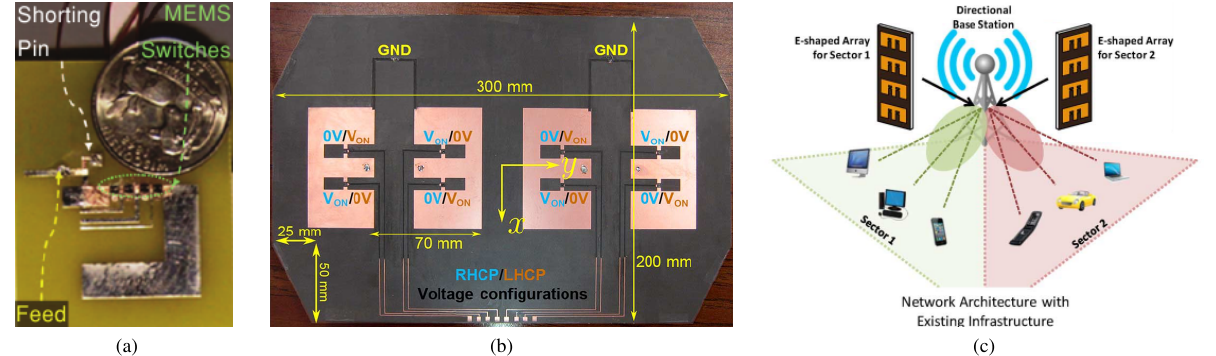
FIGURE 28. Reconfigurable E-shaped patch antennas and variations. (a) Frequency reconfigurability for multiradio platforms [31]. (b) RHCP/LHCP reconfigurable array for wideband base stations [17]. (c) Frequency reconfigurability for cognitive radio base stations